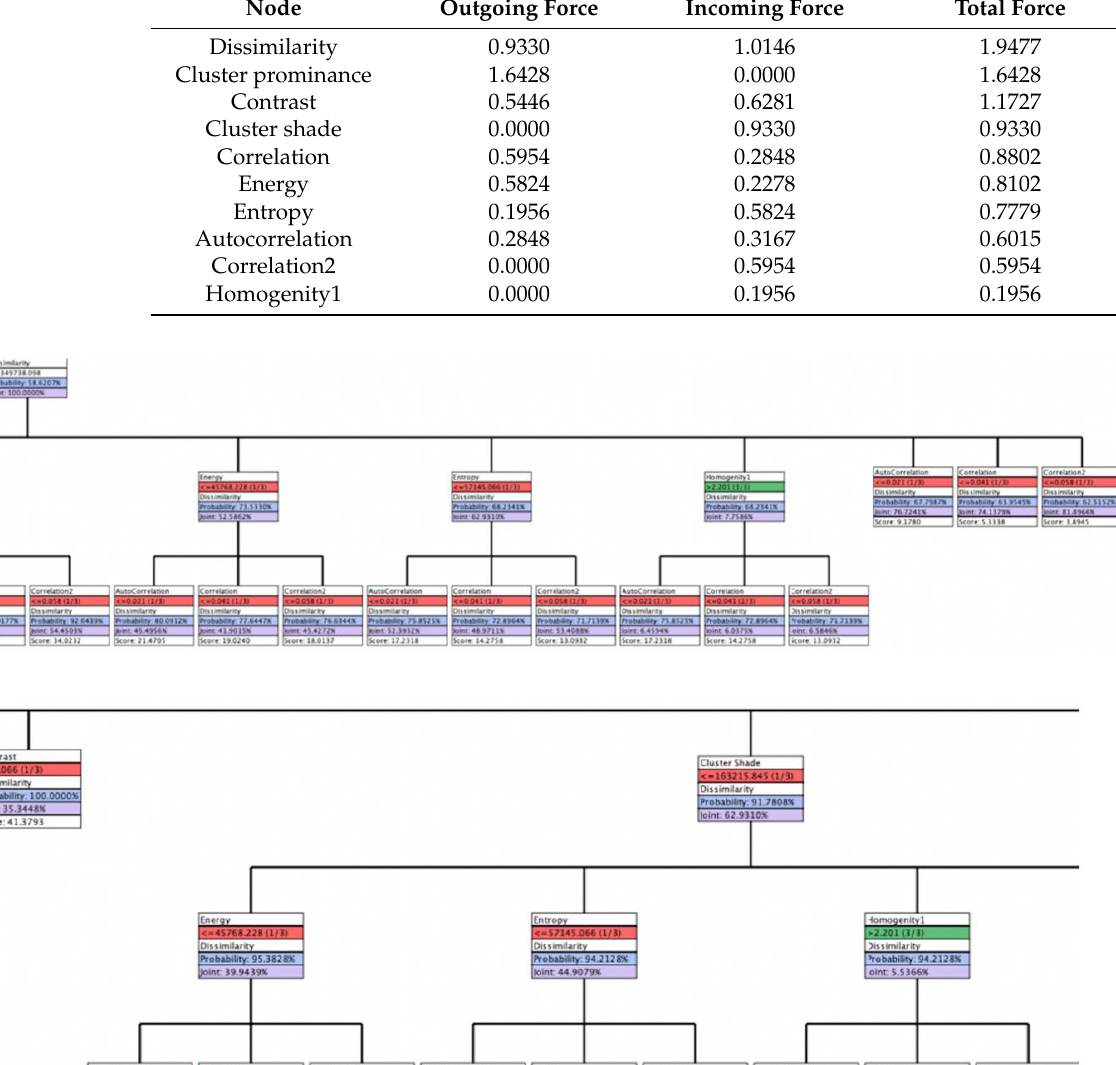
Table 1. Node force of extracted GLCM features from congestive heart failure signals. Node Outgoing Force